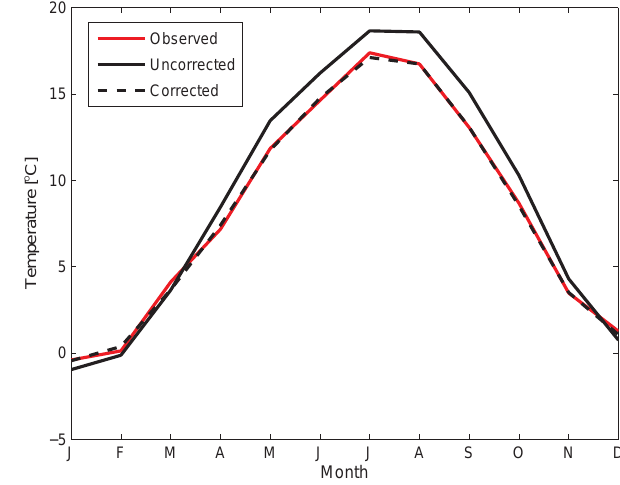
Fig. 8. Non-exceedance probabilities of 10-day winter precipitation sums for the period 1979–1995. The 10-day precipitation sums are area-weighted averages.